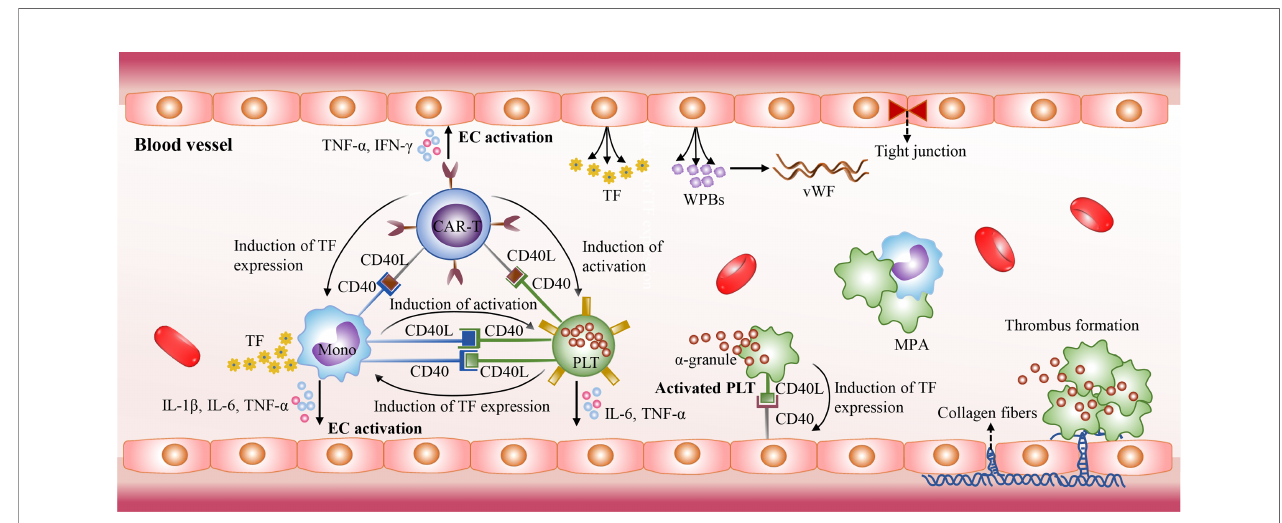
FIGURE 4 | The mechanisms of CRS-related coagulopathy. The CD40/CD40L interactions also play an essential role in CRS-related coagulopathy. The activated CAR-T cells with high CD40L expression mediate platelet activation in a CD40-independent manner. Then the activated platelets express high levels of CD40L. It could stimulate endothelial cell activation, and induce the expression of TF in monocytes and endothelial cells through direct interaction with CD40. Then TF triggers the extrinsic coagulation cascade. In addition, the CD40/CD40L interactions stimulate the excessive release of cytokines, such as IL-1 b , TNF- a , and IL-6. High levels of cytokines further mediate endothelial injury and promote the release of TF and Weibel-Palade bodies (WPBs). The WPBs contains von Willebrand factor (VWF) which plays an essential role in platelet adhesion and aggregation. Due to endothelial injury, collagen fi bers are exposed and activate intrinsic coagulation